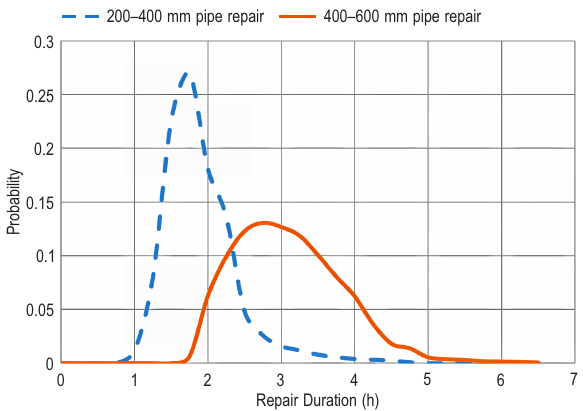
Fig. 2. Results of pipe repair simulation